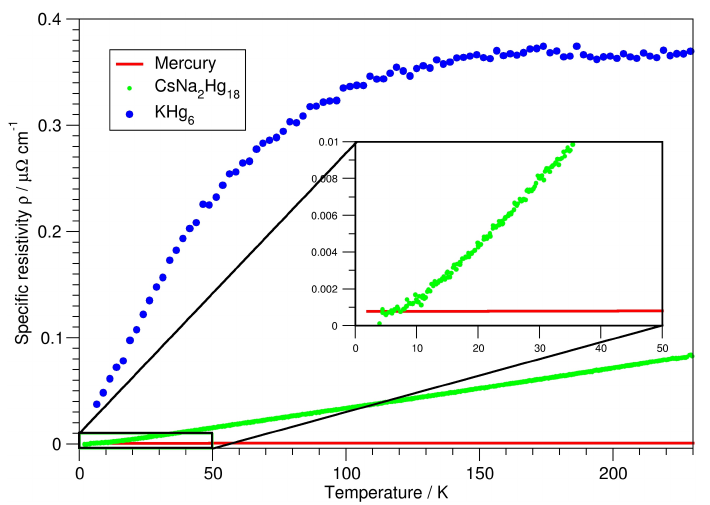
Figure 5. Specific resistivity of CsNa 2 Hg 18 (green) versus temperature, in comparison to the specific resistivities of pure mercury (red) and KHg 6